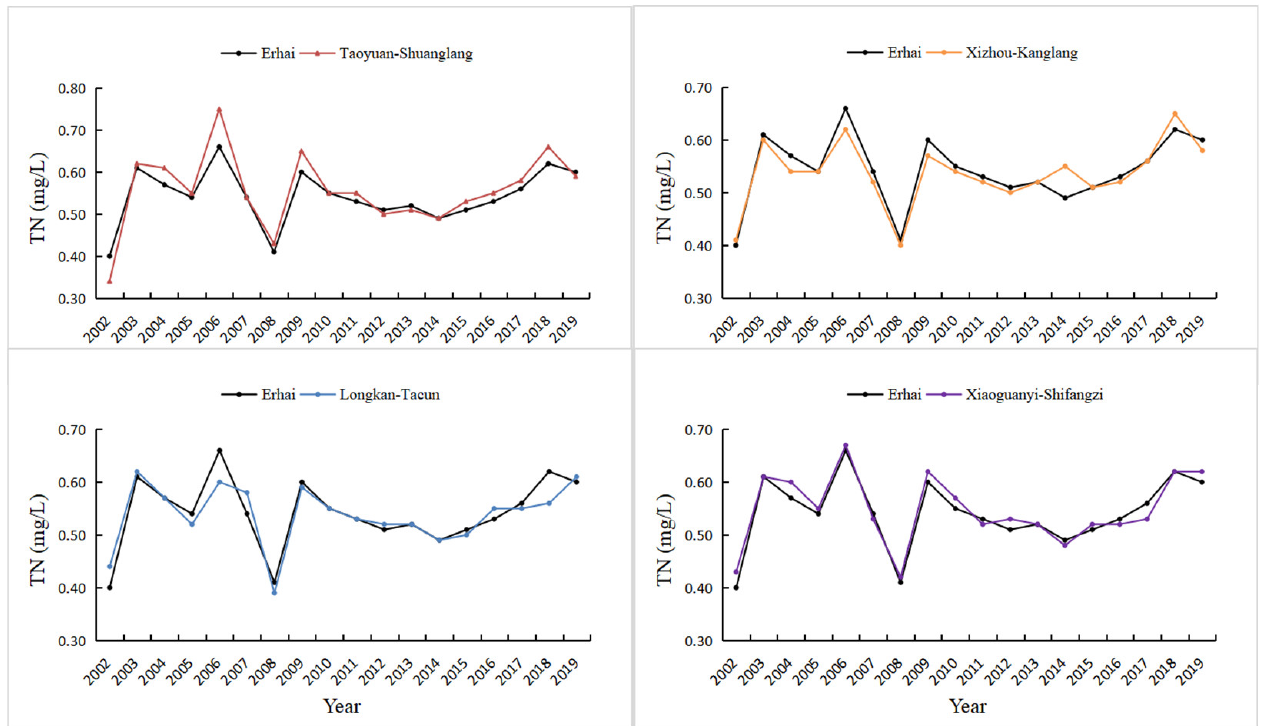
Figure 5. TN concentration of Erhai Lake and its sections in the north-south direction from 2002 to 2019.